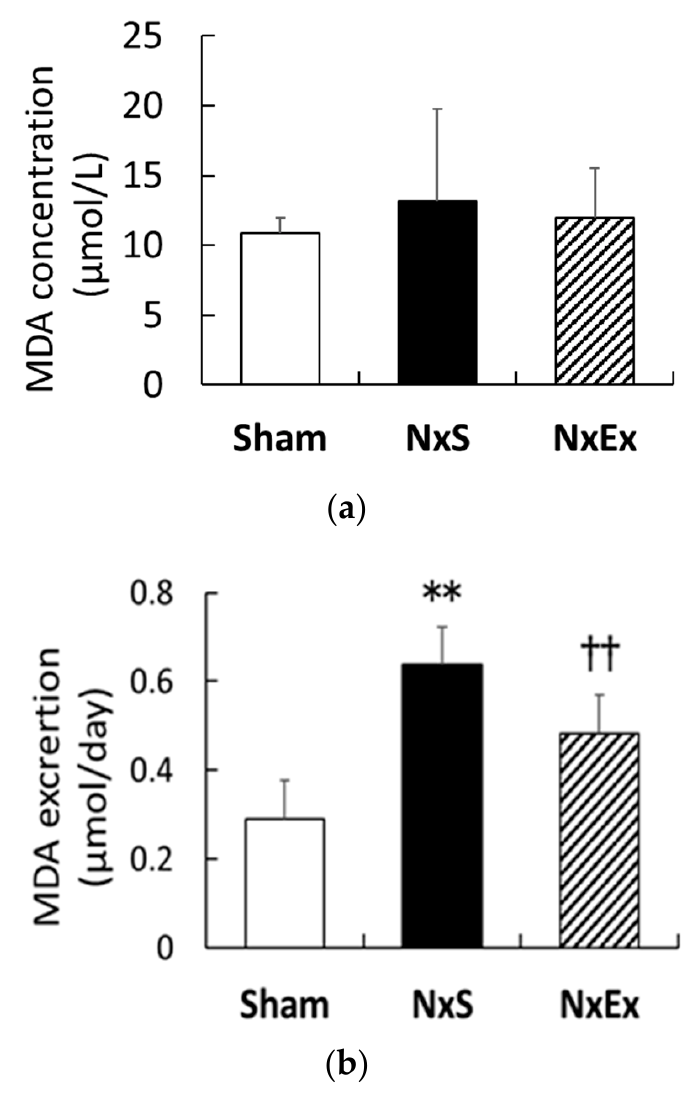
Figure 1. Effects of exercise training on plasma and urinary malondialdehyde (MDA). The plasma MDA concentration ( a ) and urinary MDA excretion ( b ) were compared among the sham operation (Sham), nephrectomy sedentary (NxS,), and nephrectomy exercise (NxEx) groups. Values are the means ± SEM. ** p < 0.01 compared with the sham group, †† p < 0.01 compared with the NxS group. Compared with the Sham group, Nx significantly increased the renal NADPH oxidase activity (46.8 ± 5.5 vs. 89.0 ± 11.5 count per minute/ µ g protein, p < 0.01), whereas exercise training significantly inhibited the Nx-increased NADPH oxidase activity (52.1 ± 4.8 count per minute/ µ g protein, p < 0.01) (Figure 2a). Nx also significantly increased the XO activity (15.4 ± 2.6 vs. 42.9 ± 4.4 mU/mg protein, p < 0.01), and exercise training significantly inhibited the Nx-increased XO activity (27.9 ± 3.7 mU/mg protein, p <